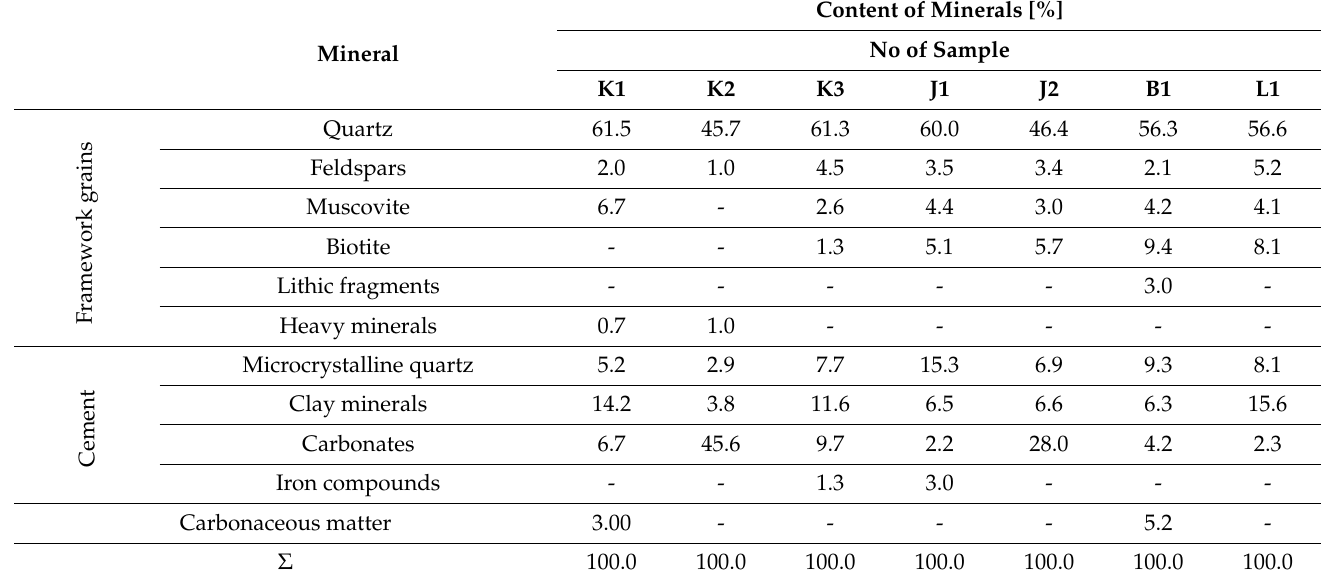
Table 1. Planimetric analysis of sandstones.